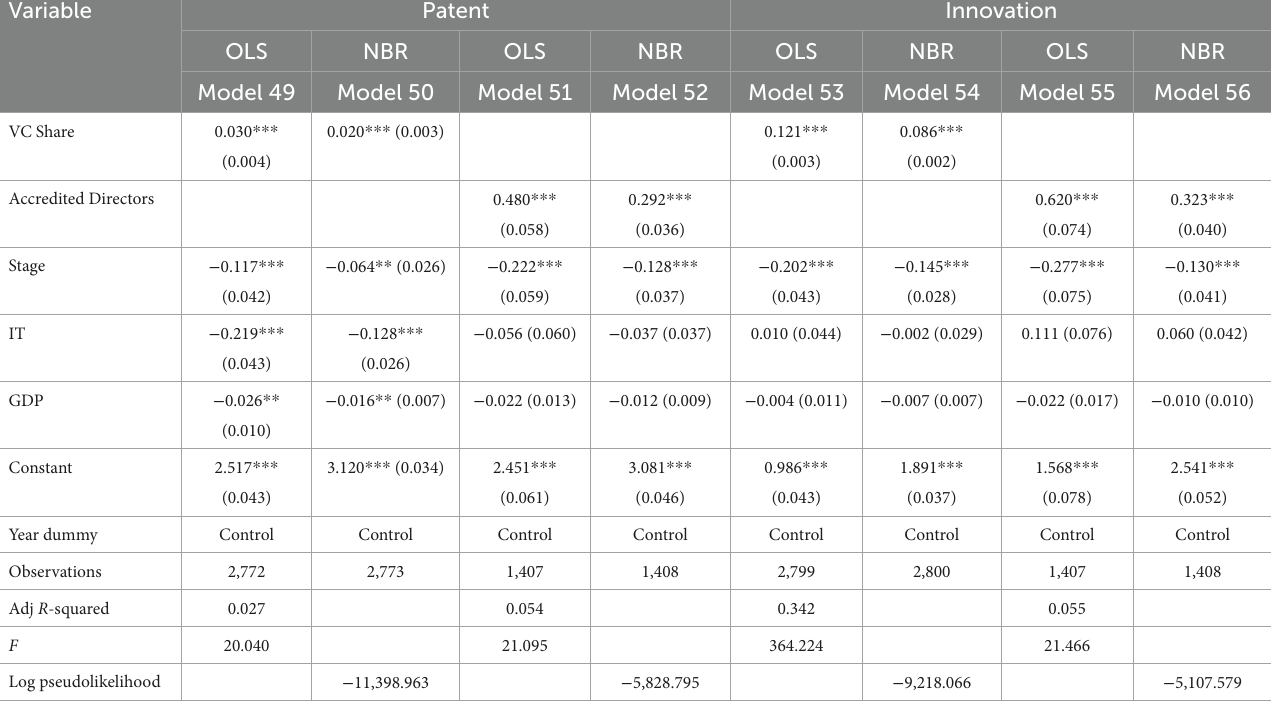
TABLE 11 Impact of VC shareholding and dispatched directors on enterprise innovation